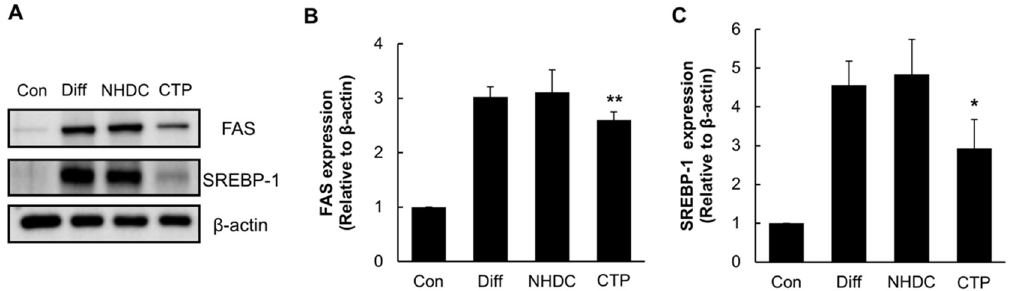
Figure 5. Effect of NHDC analogue on lipogenesis during the adipogenic differentiation. hASCs were treated with NHDC or its analogue along with the adipogenic differentiation medium for 14 days. Western Blotting was performed against lipogenic markers including FAS and SREBP-1 ( A ). Densitometric analysis of Western Blotting of FAS ( B ) and SREBP-1 ( C ). Bands were densitometric analyzed by using ImageJ software. The results are expressed as the mean values ± SD ( n = 3); * p < 0.01, ** p < 0.05 as compared to the differentiation group. Con, control group cultured in growth medium only; Diff, differentiation group cultured in adipogenic differentiation medium.